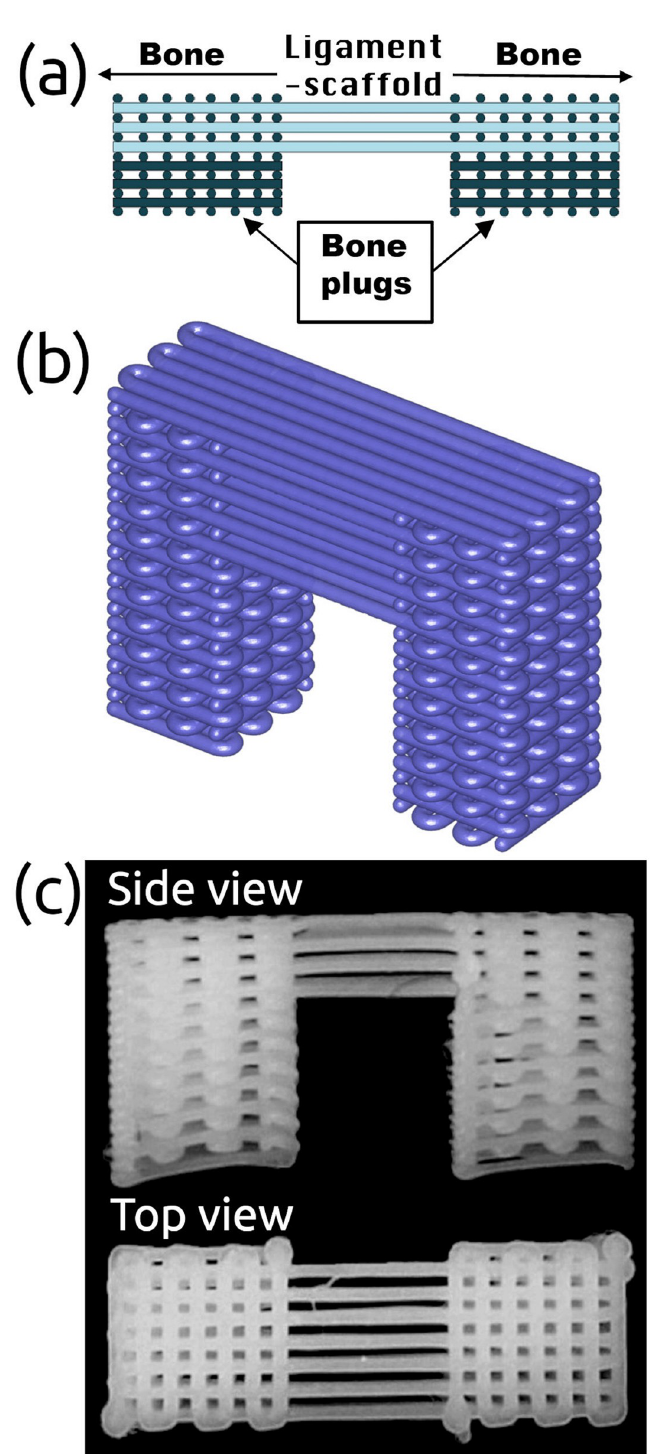
Fig 2. Design of multiphasic bone-ligament-bone scaffold. (a) A schematic 2D view and (b) 3D rendering of the scaffold design, and (c) an example fabricated scaffold.